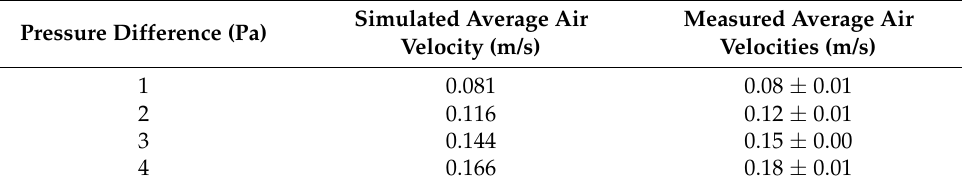
Table 3. Simulated average velocity and measured average air velocities (means ± SD, n = 3) at the orifice between the emission and the detection chamber.